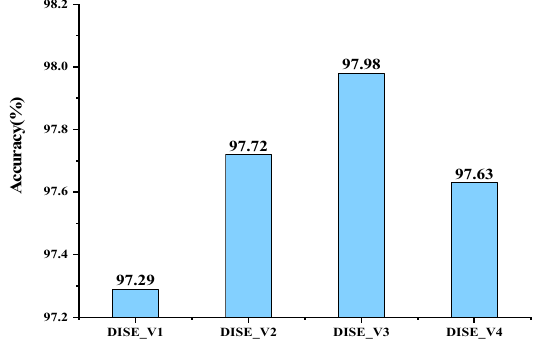
Figure 13. The effect of different dilated rates on the accuracy of the convolution neural network. Table 7. The operation effect of network structure under different dilation rate combinations.